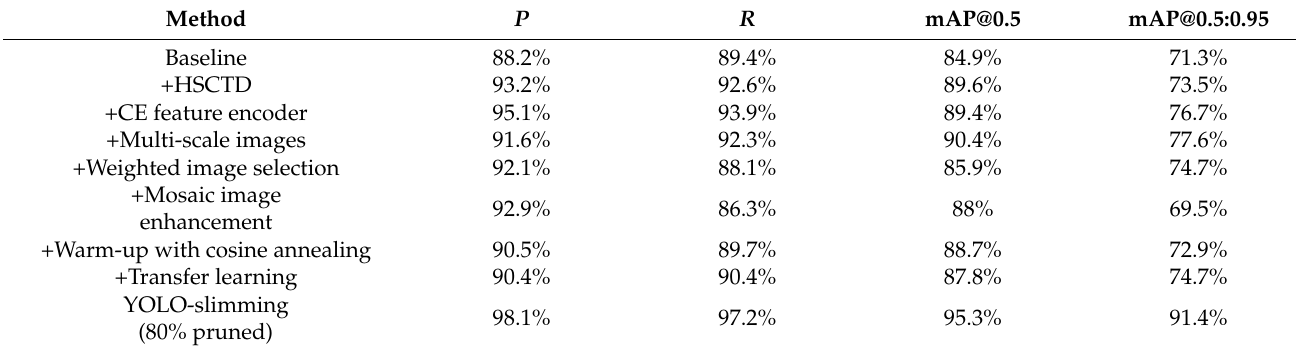
Table 3. Ablation experiments.